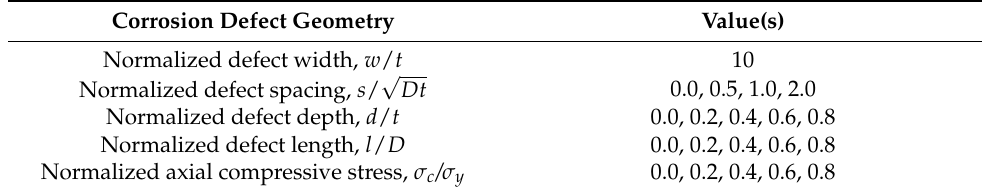
Table 1. Corrosion defect geometry parameters. Corrosion Defect Geometry Value(s) Normalized defect width, w / t 10 √ Dt Normalized defect spacing, s / Normalized defect depth, d /